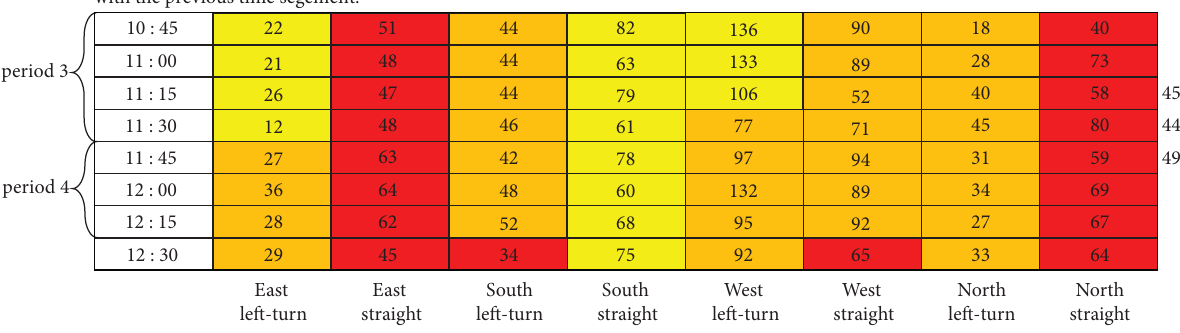
Figure 3: Example of the outlier processing of time segment division of trafc-fow sequence of 8